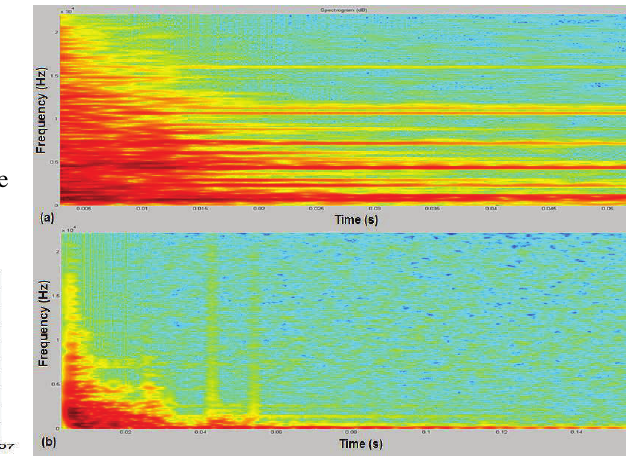
Figure 4. Spectrogram of free-decay response signal of dry plate (a) and wet plate